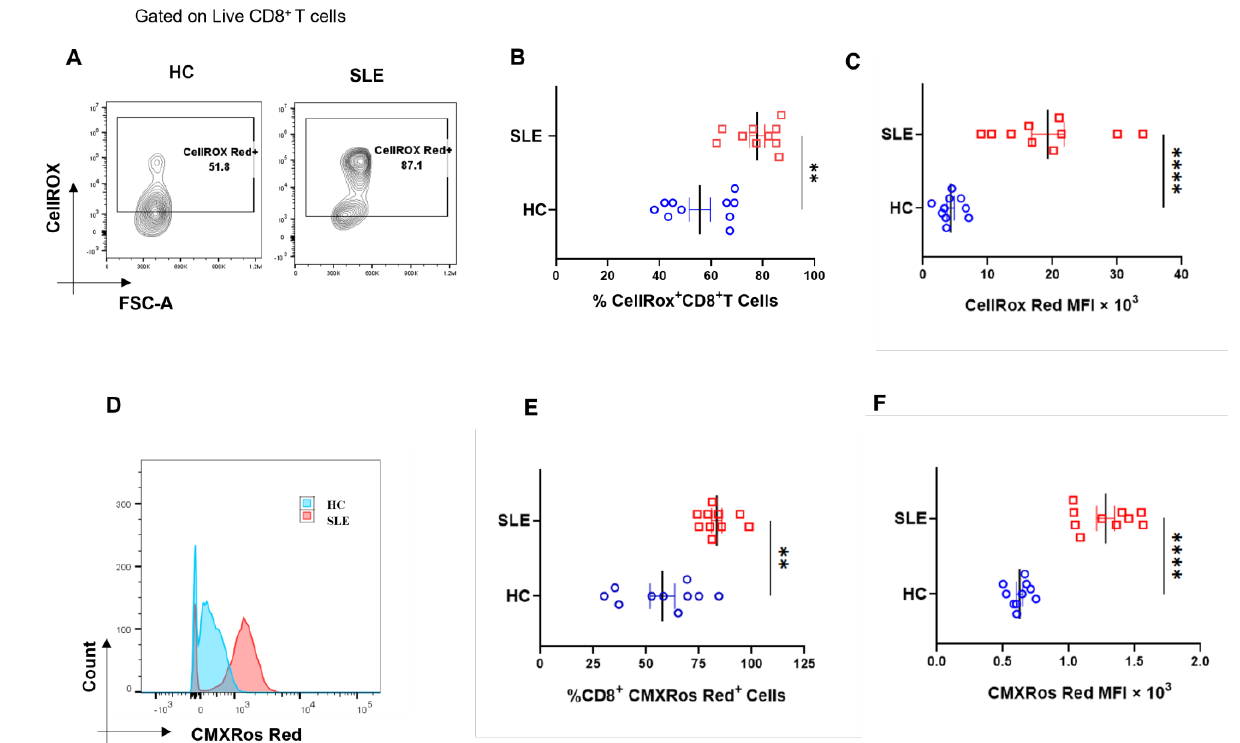
Figure 3. Cellular ROS (cROS) and mitochondrial hyperpolarization in SLE CD8 + T cells. CD8 + T cells from SLE displayed higher cellular ROS than healthy controls. Representative flow cytometry plots showing CD8 + T cells from HC ( n = 10) and SLE ( n = 10) ( A ) stained with CellROX Red to determine cellular ROS in CD8 + T cells and cumulative graphical representation of the % cells expressing CellROX ( B ). Graphical representation showing difference in the median fluorescence intensity (MFI) of CellROX between HC and SLE ( C ). Representative flow cytometry plots showing CD8 + T cells from HC ( n = 10) and SLE ( n = 10) stained with CMXROS Red to determine mitochondrial hyperpolarization ( D ). Cumulative graphical representation of the % cells expressing CMXROS Red ( E ) and graphical representation showing difference in the median fluorescence intensity (MFI) of CMXROS Red between HC and SLE ( F ). Error bar indicates SEM. Mann – Whitney U test has been used to compare the groups. p < 0.01 was considered to be very significant (**); p < 0.0001 was considered extremely significant (****).